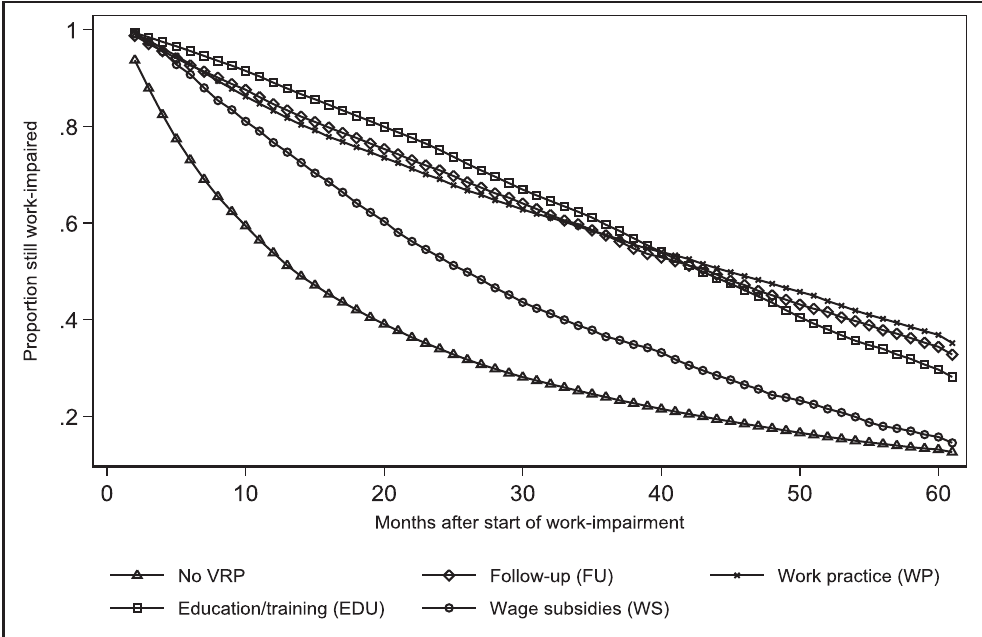
Figure 2 Survival curves by vocational rehabilitation program (VRP) status. Young people 18-29 years of age in the period